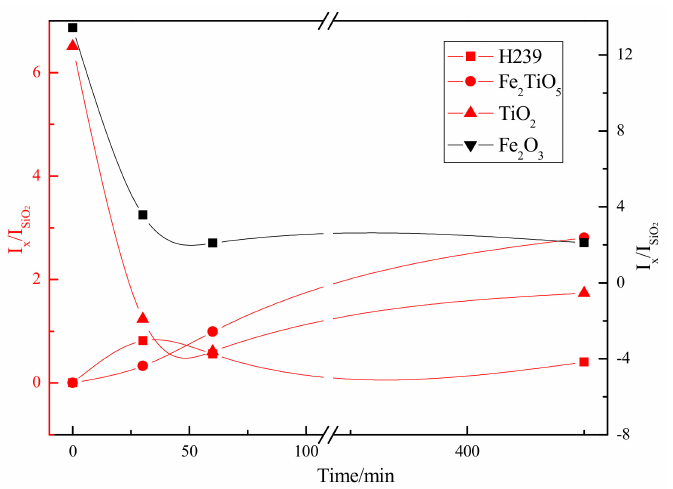
Figure 6. Ratio of the characteristic peak intensity of objective oxides to SiO 2 in Figure